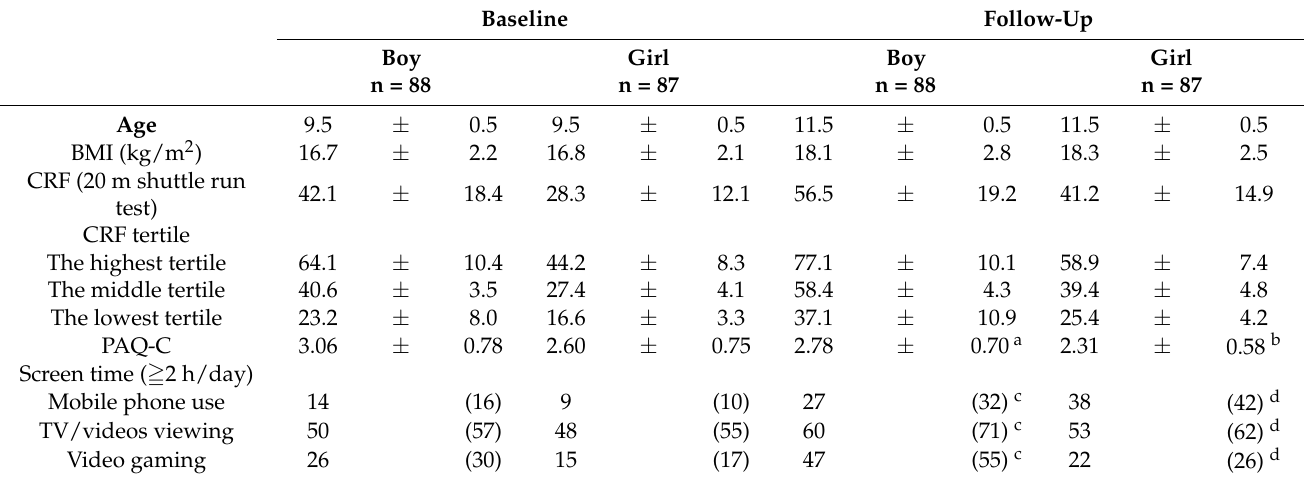
Table 1. Characteristic of the study sample (n = 175).